Question: What caption would you write for this figure?
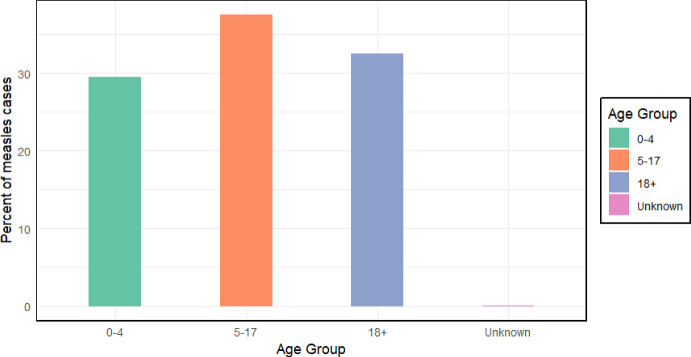
Answer: Percentage of measles cases in Texas by age for the year 2025